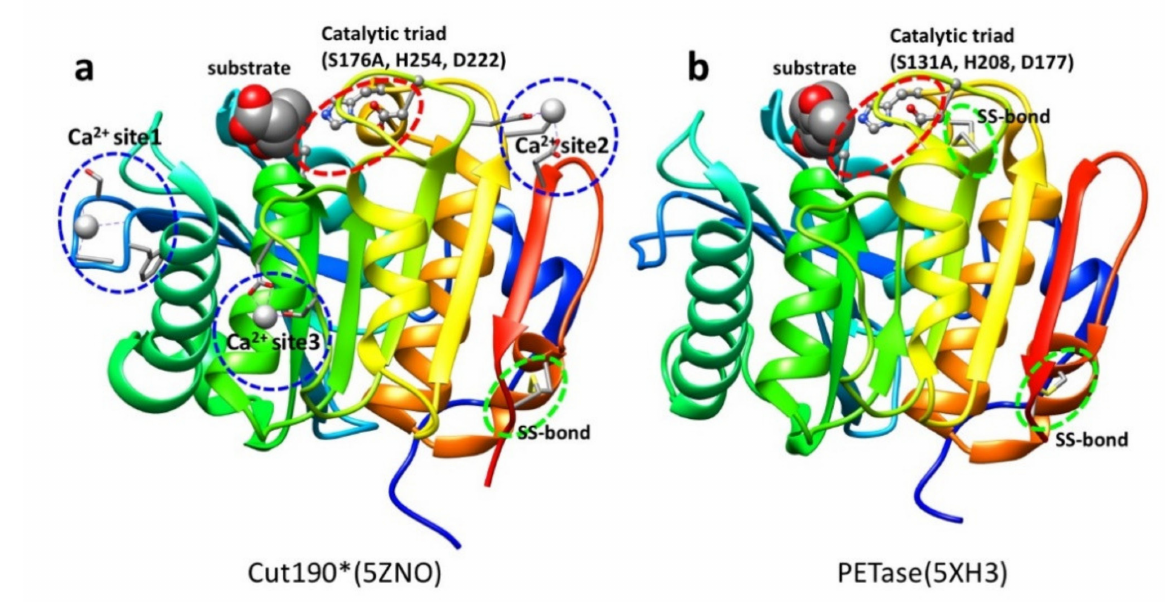
Figure 1. Comparison of overall 3D structures of Cut190* and PETase. The main chains are shown in ribbon models, the side chains of catalytic triads are shown in ball and stick models, and Ca 2+ -binding sites and disulfide bonds are shown in stick models. Substrates are shown in space-filling models. Note that serine in the catalytic triad (S176 or S131) is replaced with alanine. ( a ) Cut190* (Protein Data Bank (PDB) ID: 5ZNO), which has three Ca 2+ binding sites and one disulfide bond. The bound substrate (ethyl succinate) is taken from PDB ID: 5ZRR. ( b ) PETase (PDB ID: 5XH3), which has no Ca 2+ binding site and two disulfide bonds. Reproduced from Kawai et al. Appl Microbiol Biotechnol . 2019, 10 , 4253–4268